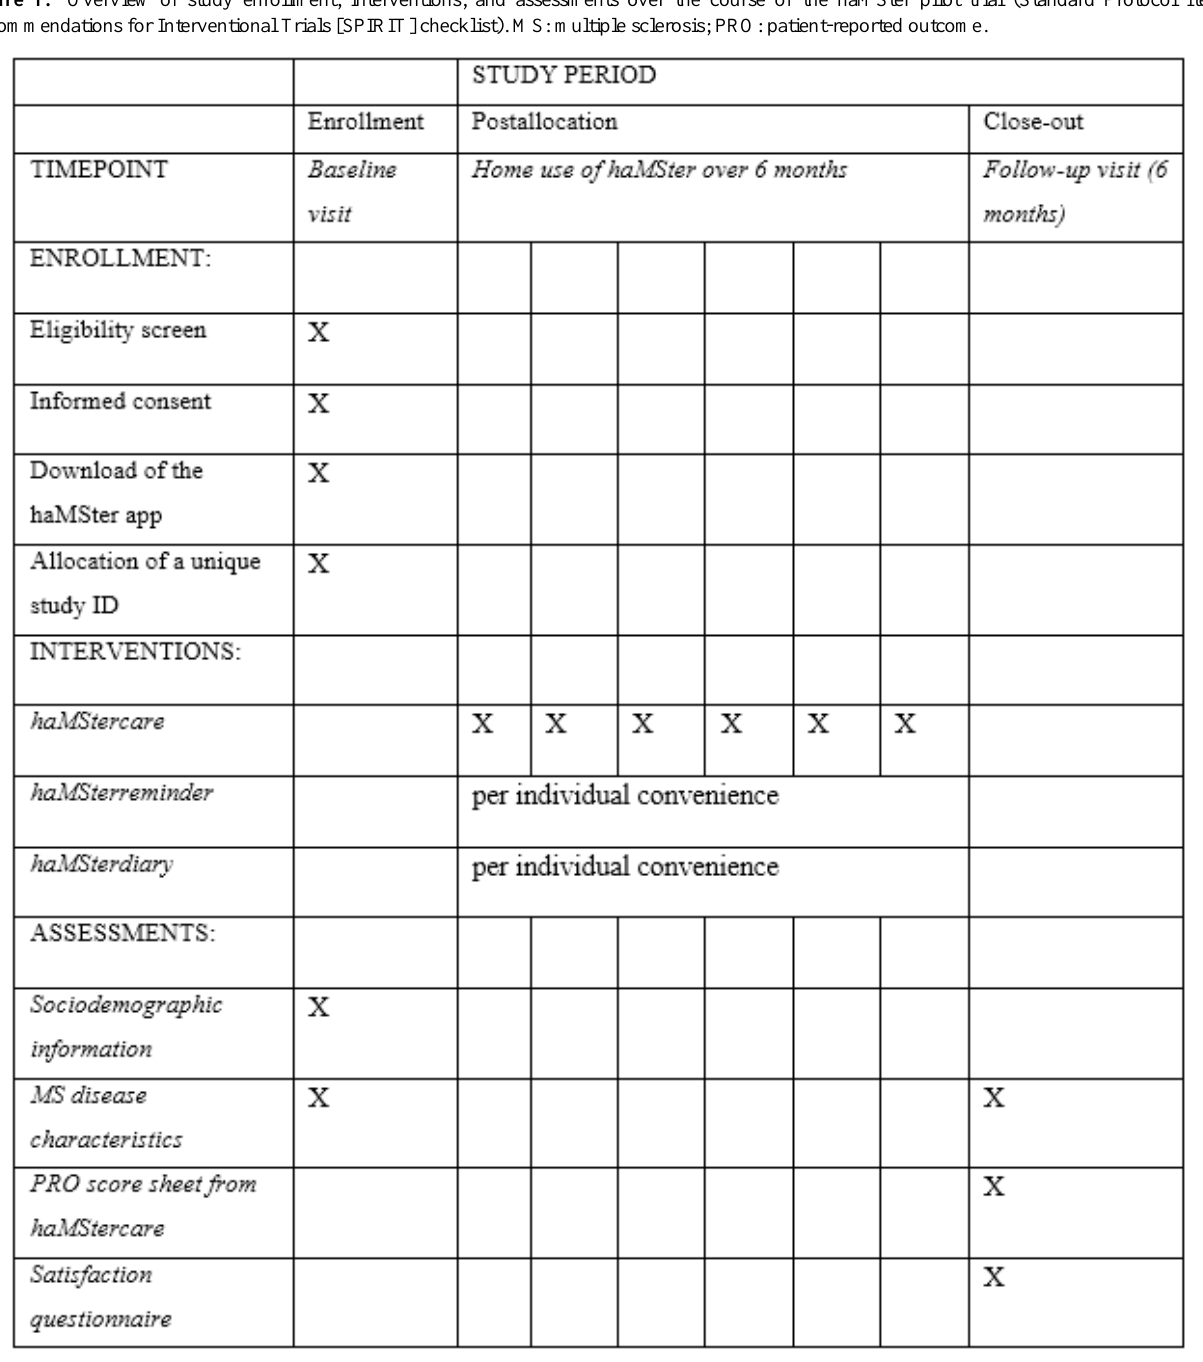
Figure 1. Overview of study enrollment, interventions, and assessments over the course of the haMSter pilot trial (Standard Protocol